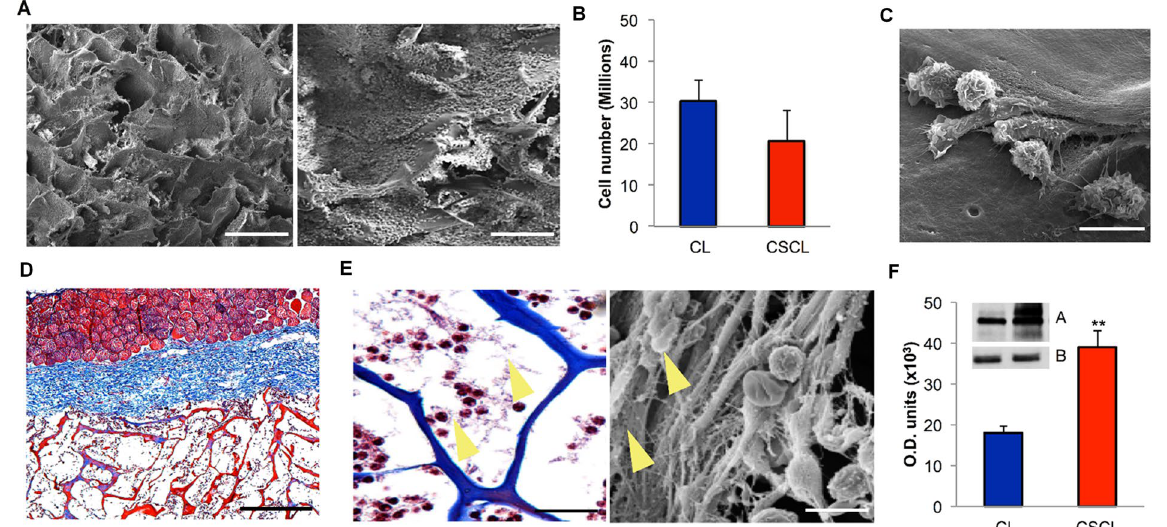
Figure 2. Infiltrating cells after 1 day from implantation in CSCL scaffold. ( A ) Representative SEM images showing the CSCL scaffold’ surface completely covered by cells in two different magnifications (scale bars: 200 μ m and 100 μ m). ( B ) Total number of cells recovered by CSCL and CL counted by flow cytometry. Graph represents mean values ± SD (n = 3). ( C ) SEM magnification to evaluate the infiltrating cells morphology on CSCL (scale bar: 10 μ m). ( D ) Masson’s stained section revealed a massive infiltration of cells through the entire CSCL’ thickness coming from the surrounding vasculature (inset). (Scale bar: 200 μ m). ( E ) Magnification Masson’s stained section (on the left) and a SEM image (on the right) highlighted a high level of fibronectin on the CSCL surface (yellow arrows) (scale bars: 40 μ m and 15 μ m, respectively). ( F ) Evaluation of fibronectin level of expression was performed on protein extracts from CL and CSCL scaffolds. Densitometric analysis, y-axis shows the optical density of protein expression (A) normalized against the control (B, GAPDH). Results are shown as means of three replicates ± SD. ** p ≤